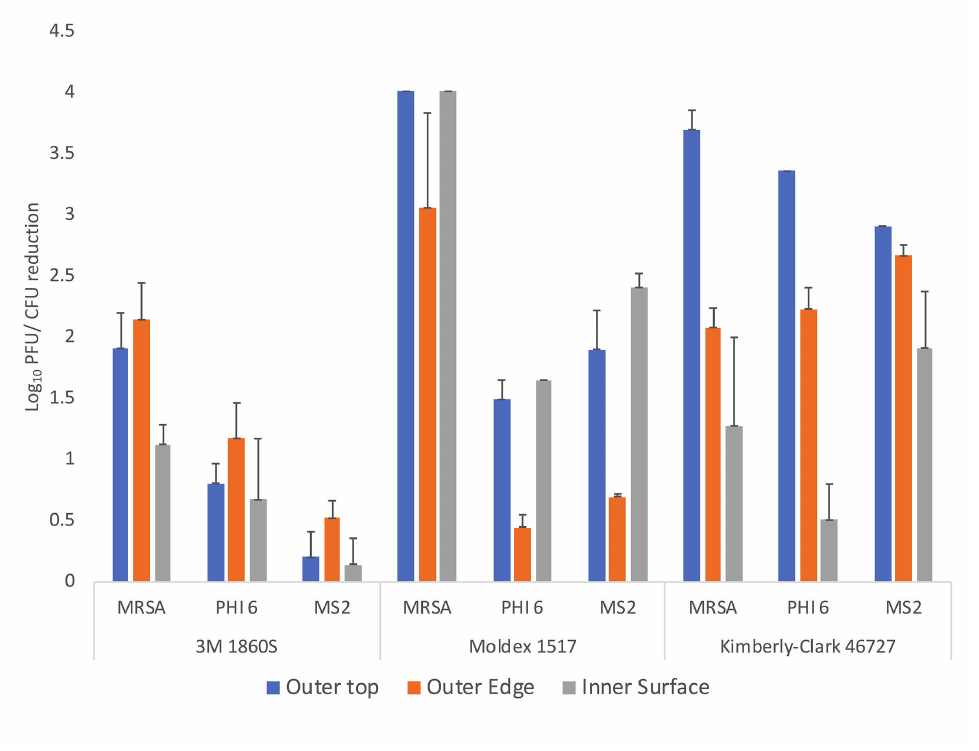
Figure 2. Efficacy of ultraviolet-C (UV-C) light for decontamination of methicillin-resistant Staphylococ- cus aureus (MRSA), bacteriophage MS2, and bacteriophage Phi6 on 3 different N95 respirators (3M 1860S, Moldex 1517, and Kimberly-Clark 46727). Aliquots of 10 μL containing 10 6 colony-forming units (CFU) or plaque-forming units (PFU) of the test organisms in the simulated mucus suspension were spread to cover an area of 1 cm 2 on 3 different areas on the respirator surface (top exterior, edge exterior, and interi- or) as shown in Figure 1. The respirators were exposed to a 60-second cycle of UV-C inside a UV-C box. Error bars indicate standard